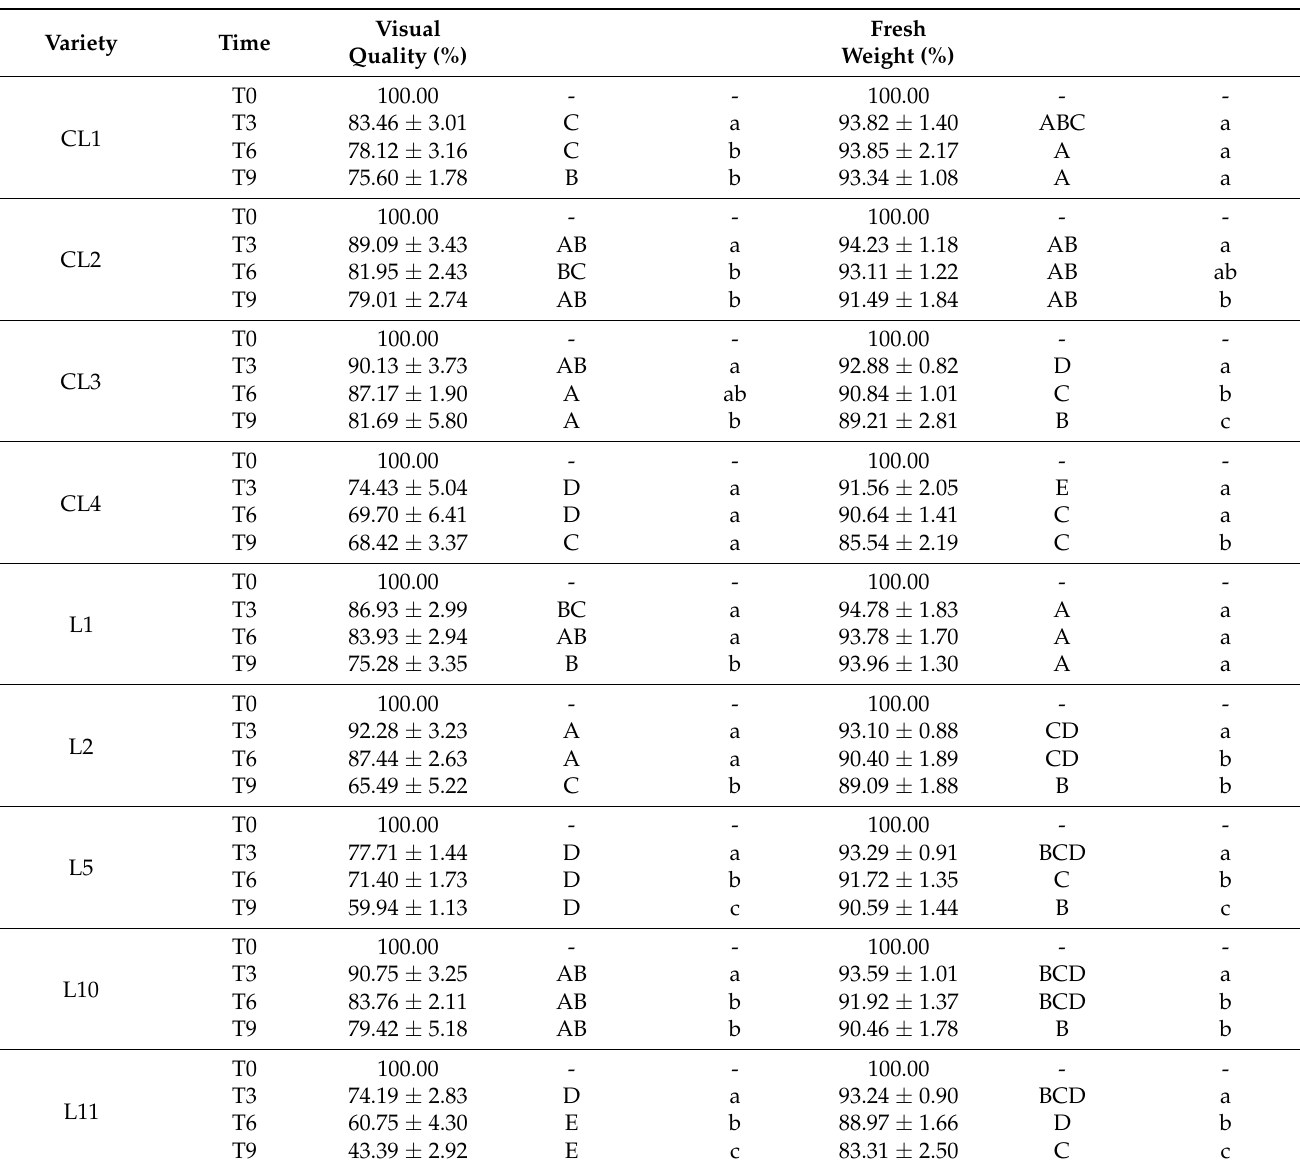
Table 3. Visual quality (%) and fresh weight (%) of nine harvested lettuce varieties measured at 0 (T0), 3 (T3), 6 (T6) and 9 (T9) days after conservation under chamber conditions. Values are the mean ± SE of four replicates per landrace. The mean is subjected to a one-way ANOVA. Different capital and lowercase letters indicate significant differences between varieties and storage time, respectively, at p < 0.05 by the LSD